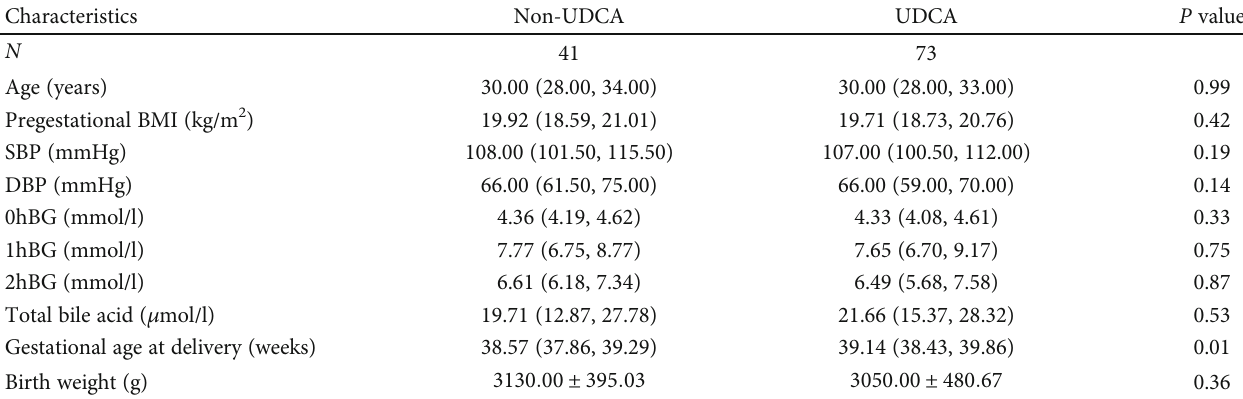
Table 2: Characteristics of UDCA and non-UDCA groups.